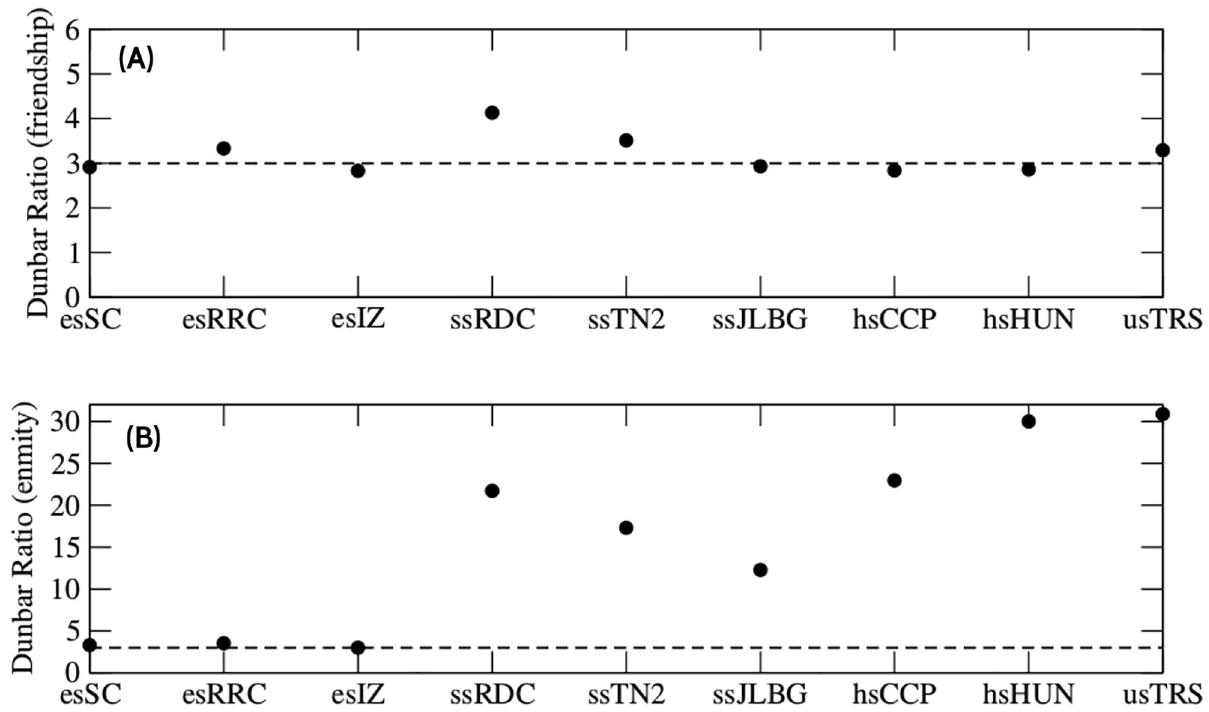
Fig 1. Dunbar’s ratios for experimental data. (A) Values obtained by dividing friend by best friends relationships. (B) Values obtained by dividing enemy by worst enemy relationships. The dashed line is Dunbar’s ratio of three.